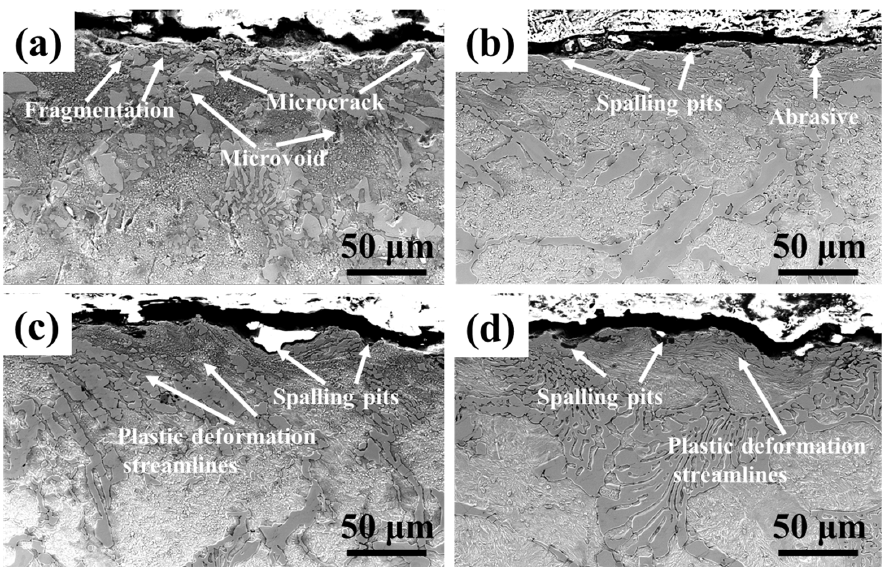
Figure 12. SEM images of the worn cross section after impact wear: ( a ) CIC ‐ 1; ( b ) CIC ‐ 2; ( c ) CIC ‐ 3; ( d ) CIC ‐ 4.